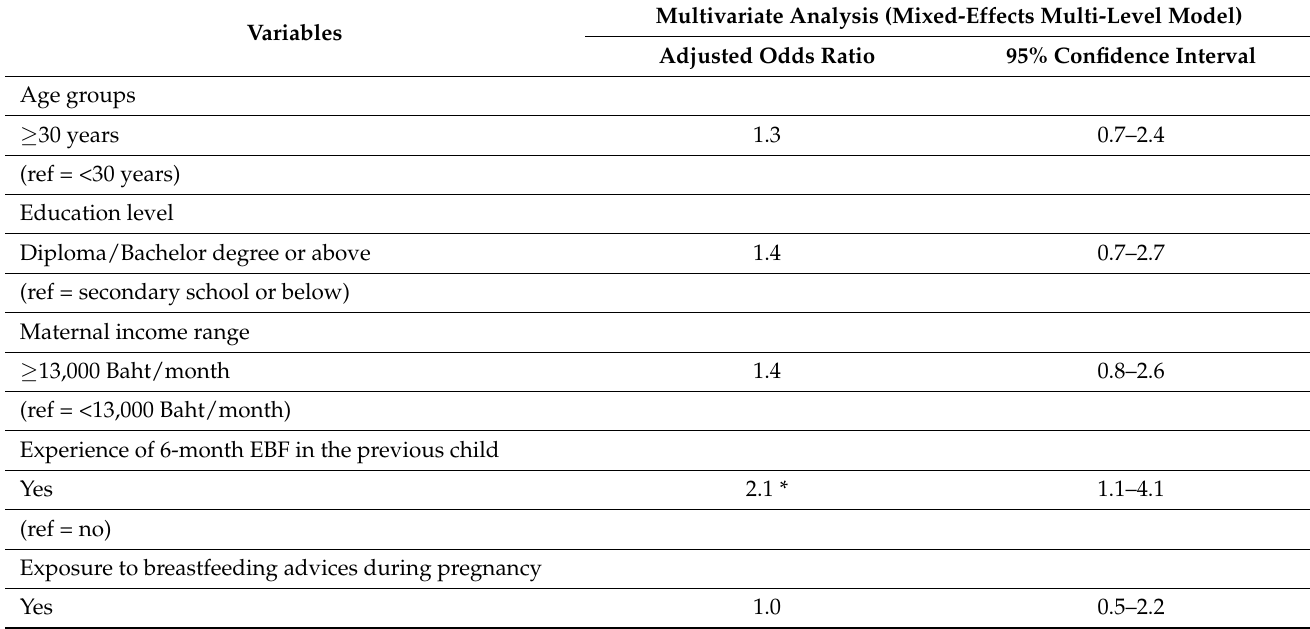
Table 4. Six-month exclusive breastfeeding (EBF) by personal attributes: multivariate analysis (partial N).